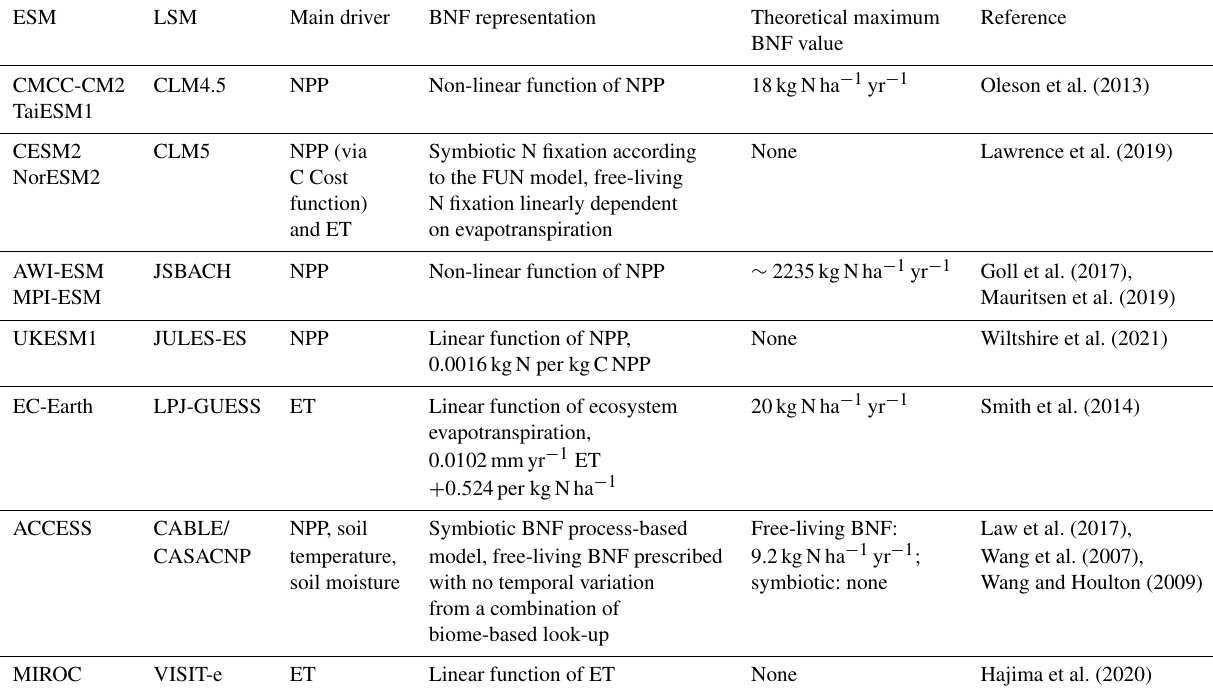
Table 1. Summary of the model’s BNF representations. The theoretical maximum BNF value refers to any limit imposed by the equations in the model, e.g. a saturation